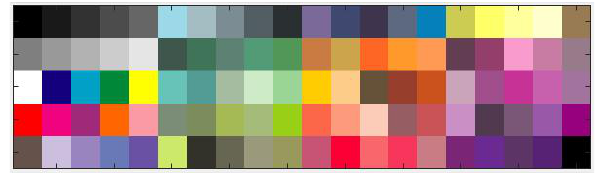
Figure 12: Color table presented to participants on